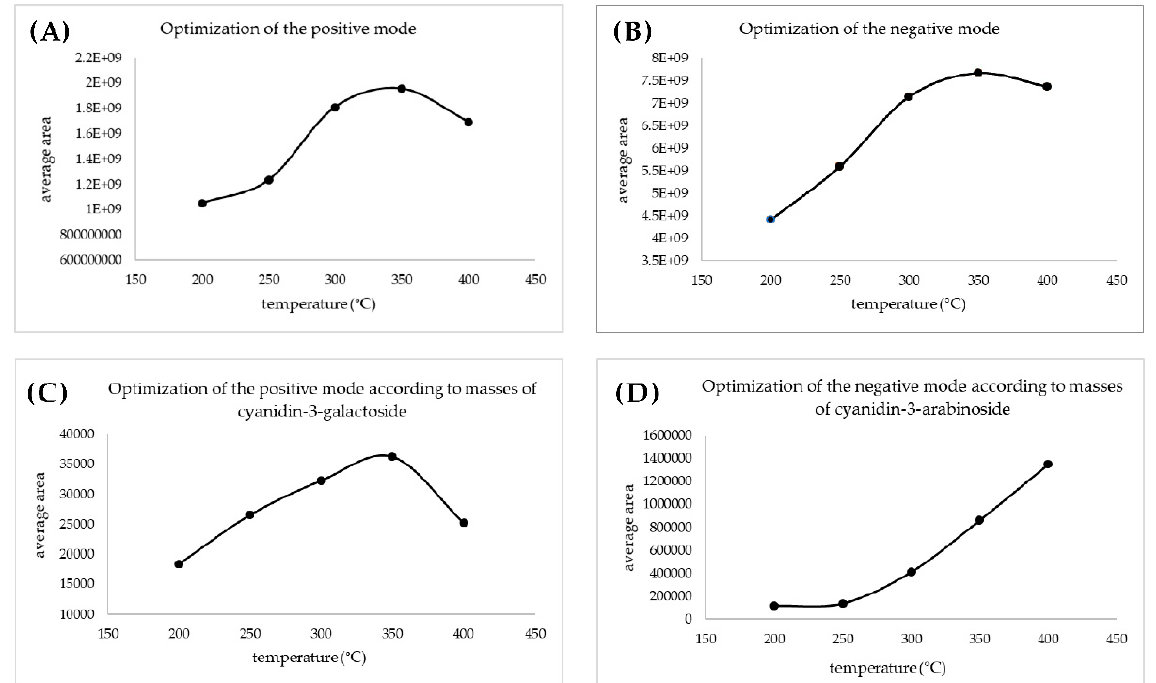
Figure 3. Optimization of the ionization temperature for positive ( A ) and for the negative mode ( B ) based on the areas obtained from the integration of the chronogram; optimization of the ionization temperature based on the areas obtained from the integration of extracted masses for positive ( C ) and for negative ( D ) mode.